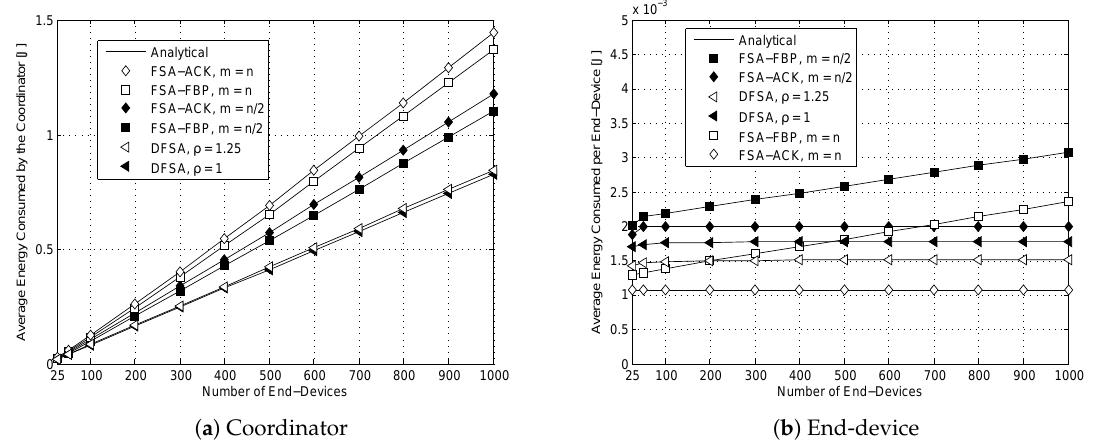
Figure 9. Network coordinator and end-device average energy consumption (Joules) depending on the number of end-devices when using the optimal FSA-ACK, FSA-FBP and DFSA